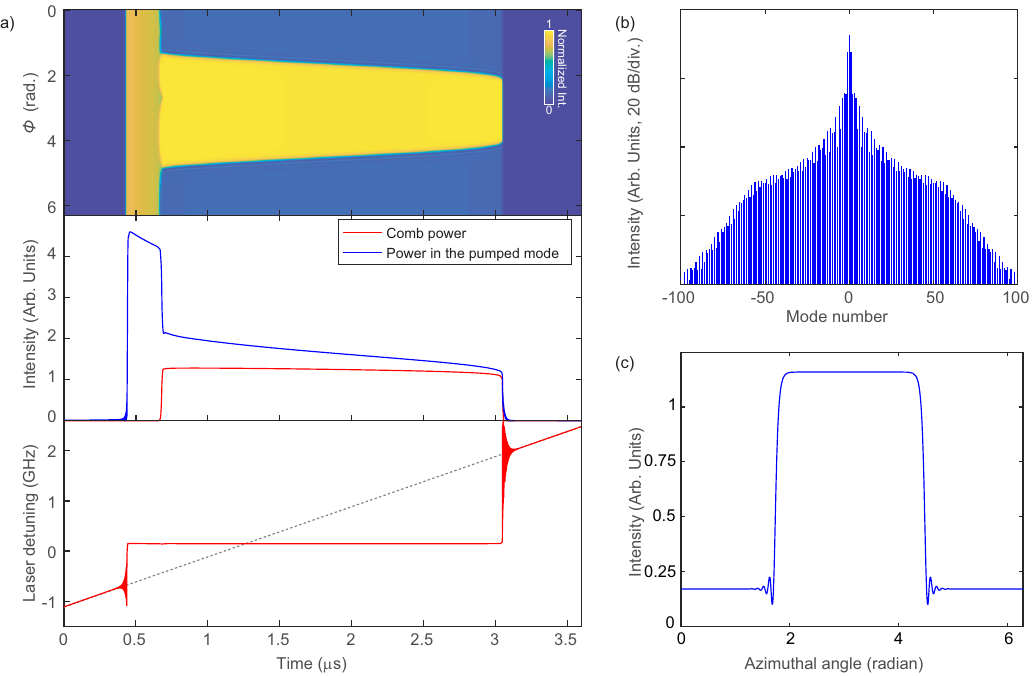
Fig. 5 Numerical simulations of platicon microcomb generation with laser self-injection locking. a Dynamic evolution of the microresonator intracavity intensity (upper panel), the intracavity comb power and the power in the pumped resonance (middle panel), and the laser detuning of the semiconductor laser with respect to the cold microresonator resonance (bottom panel) as the laser cavity resonance frequency is swept downwards across the microresonator resonance. The dashed line in the bottom panel indicates the lasing frequency trajectory if the optical feedback for self-injection locking is absent. b The platicon spectrum at the time of 2.1 μ s. c The temporal pro fi le of the platicon corresponding to the microcomb spectrum in ( b